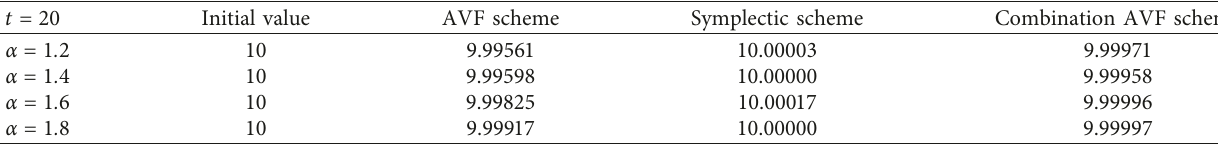
Table 2: The mass values of three different schemes with τ � 0 . 02 at t �